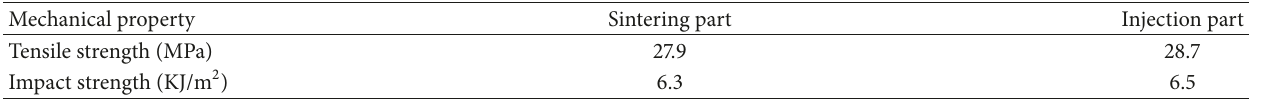
Table 4: Comparison of mechanical properties between sintering parts and injection